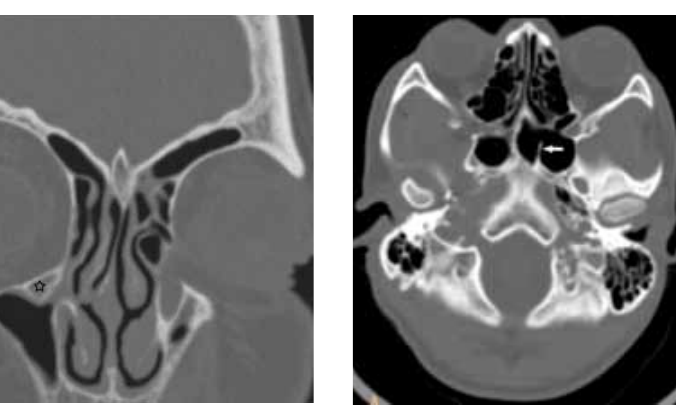
Fig. 1. Agger nasi – left (X). Fig. 2. Agger nasi – sagittal (X). Fig. 3. Bilateral bulla ethmoidalis (X)